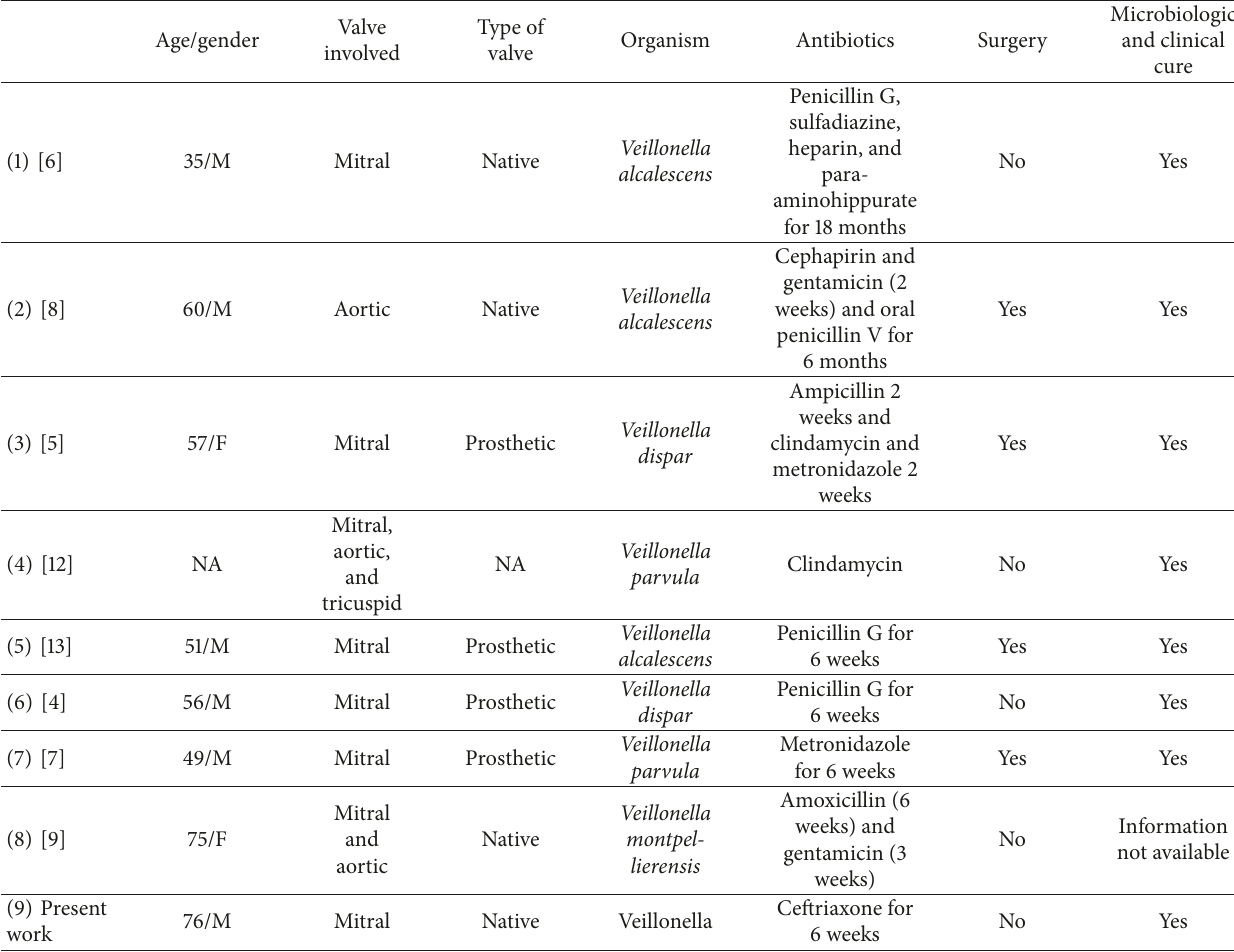
Table 1: Cases of endocarditis due to Veillonella